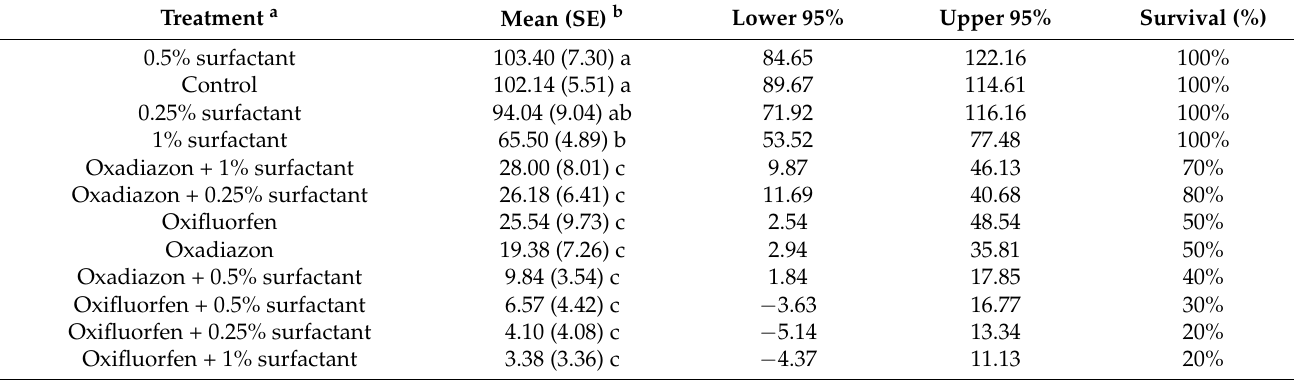
Table 2. Reduction of shoot fresh weight (mean ± SE) and survival rate of 8–9 cm tall Solanum rostratum Givat Yoav plants following oxadiazon and oxyfluorfen application, with or without